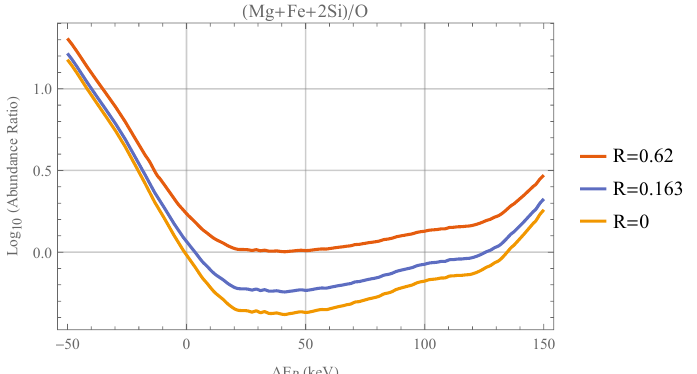
Figure 2. Oxygenation ratio R 1 for different metal ratios R 2 . The quantity ∆ E R “ 0 for our values of the constants. Planetary cores form only when this quantity exceeds 1 (0 on our log